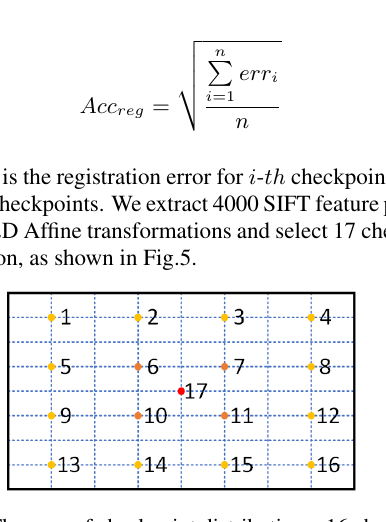
Figure 5. The map of checkpoint distributions. 16 checkpoints are selected from every other grid in 8 × 8 grids. Finally including the center point, a total of 17